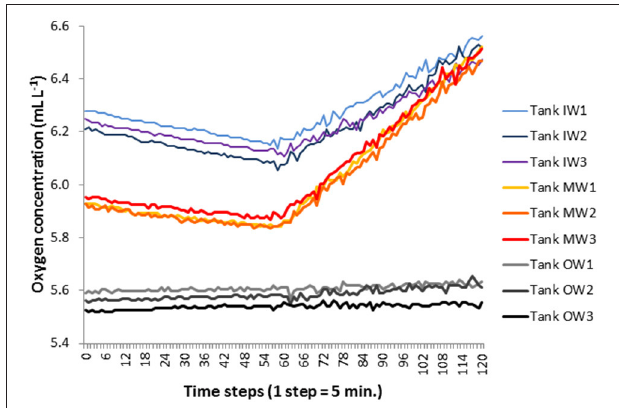
FIGURE 3 | Example of the oxygen evolution in 5-h dark incubations followed by 5-h light incubation in the water taken from the tanks on 11.9.2013 ( = day 3). The data from the three replicate tanks are shown